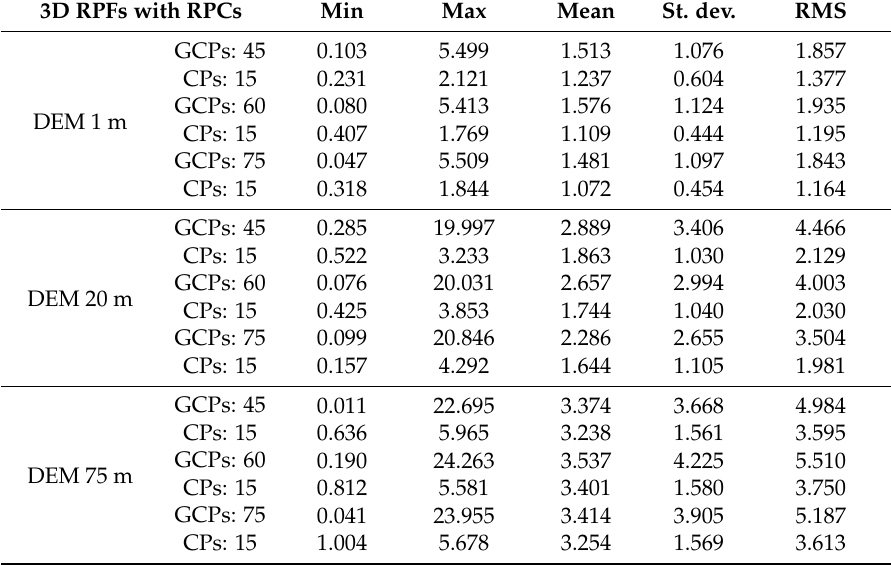
Table 4. Residuals (in meters) obtained for GCPs (45-60-75) and CPs using RPFs with RPC file. 3D RPFs with